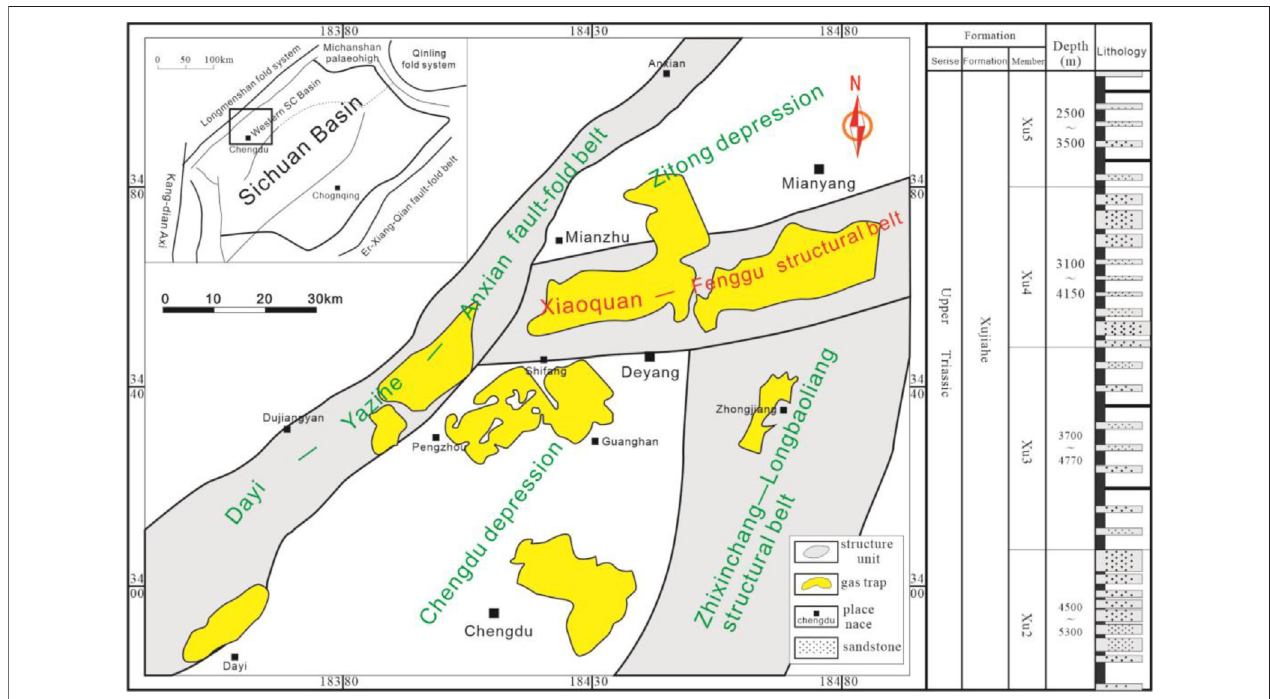
FIGURE 1 | Division of structural units and development of Xujiahe Formation in the middle part of the western Sichuan Depression.